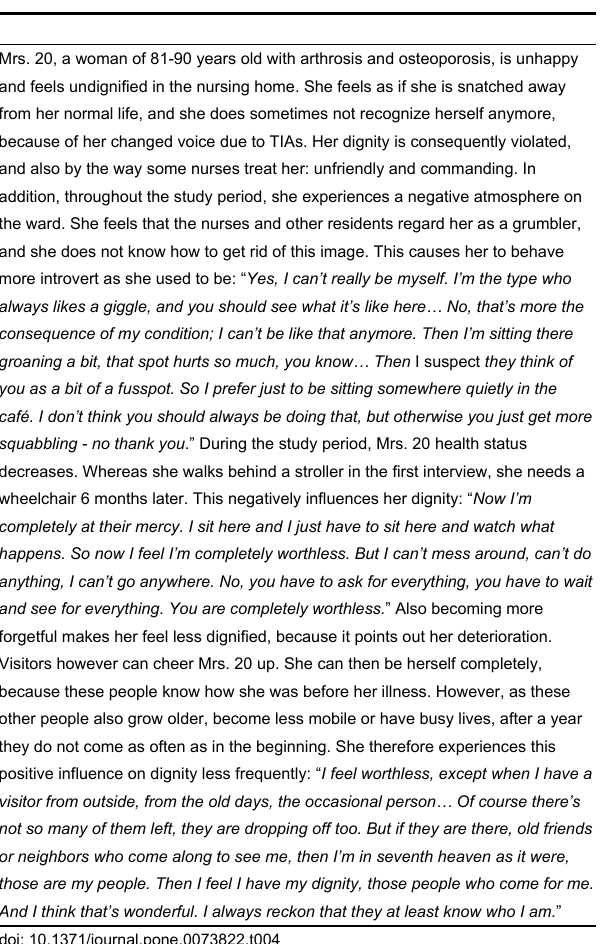
Table 3. A positive change in personal dignity: Mrs. 18. Table 4. A declining personal dignity: Mrs.